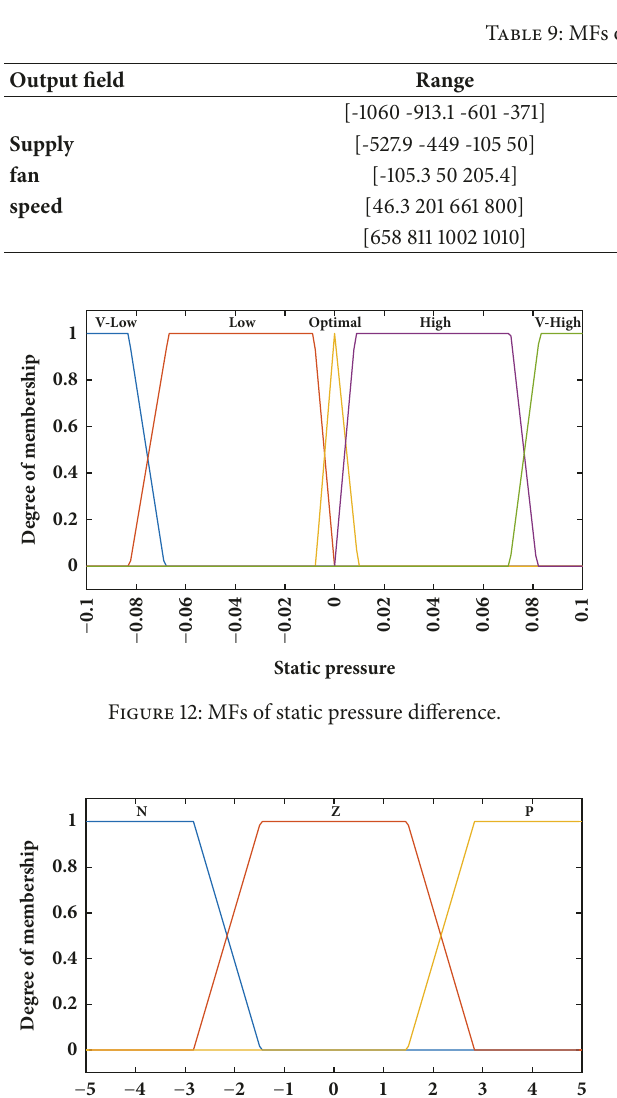
Figure 15: MFs of change in Δ CO 2